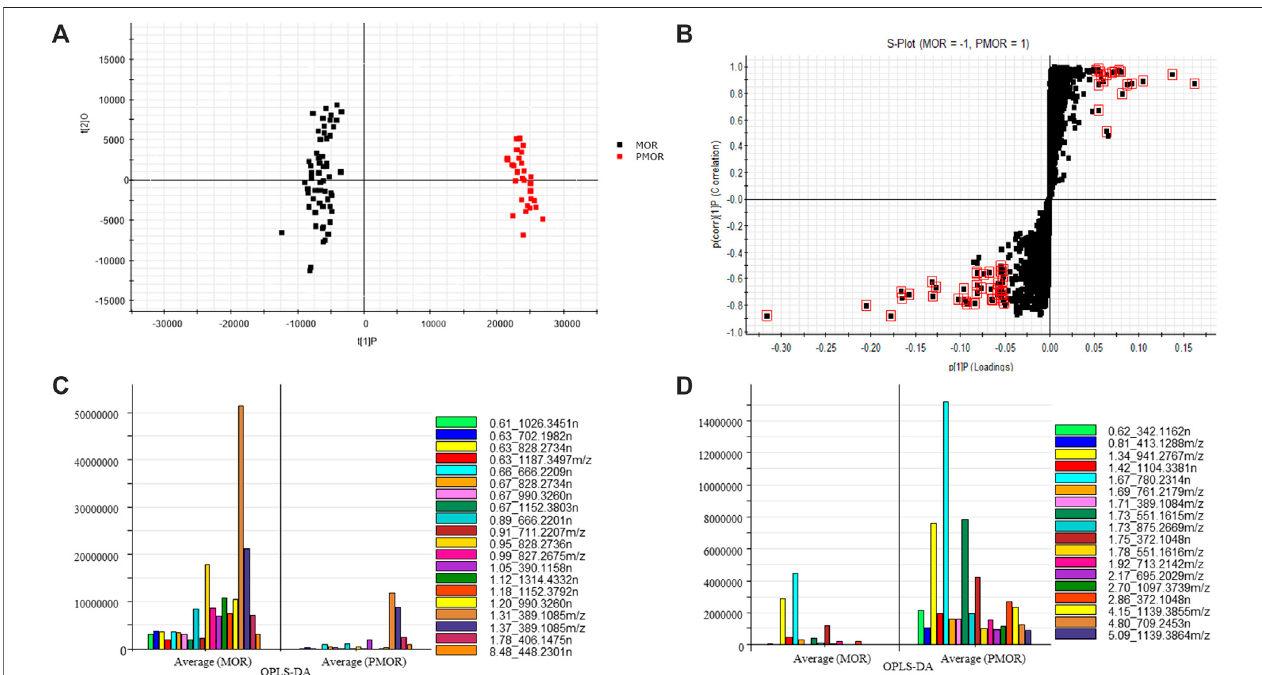
FIGURE 2 | Selected potential chemical markers from MOR and PMOR based on principal component analysis (PCA) and orthogonal partial least-squares discriminantanalysis(OPLS-DA)(inthenegativeionmode withanAcquityBEH column). (A) PCAscoreplot; (B) S-plot,thecompoundswithlargedifferencesincontent (which is marked in red squares) between MOR and PMOR; (C) the selected chemical markers with content in MOR that is higher than that in PMOR; (D) the selected chemical markers with content in PMOR that is higher than that in